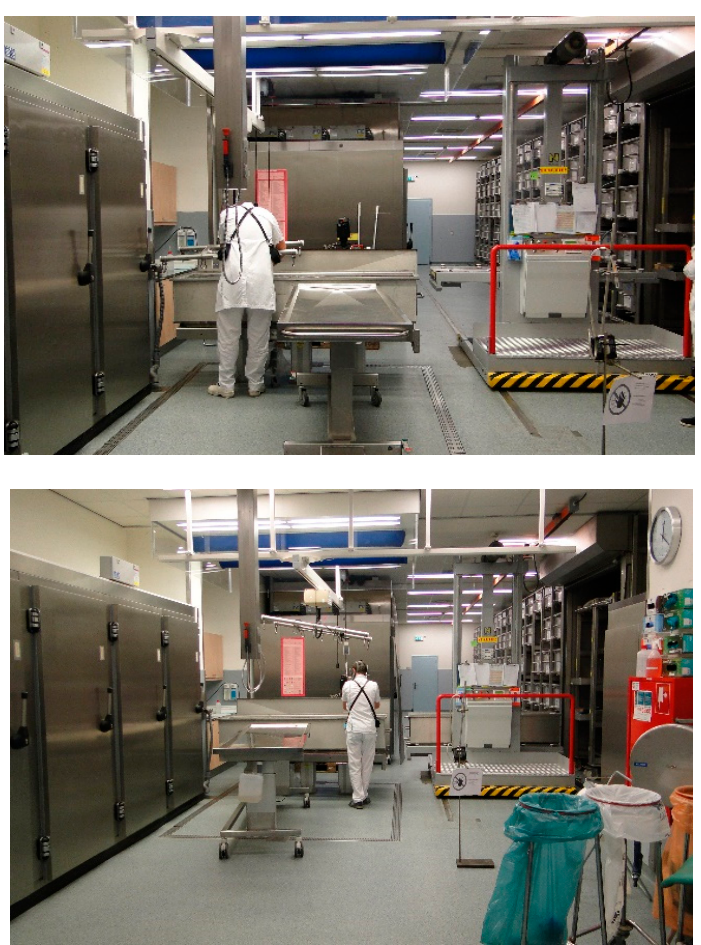
Figure 7. Take-out preparation from storage tank ( upper panel ) and place back preparation in storage tank ( lower panel ) (O-1 in Table 2). Table 3. Geometric mean concentrations (range) of FA (µg/m 3 ) at fixed locations.